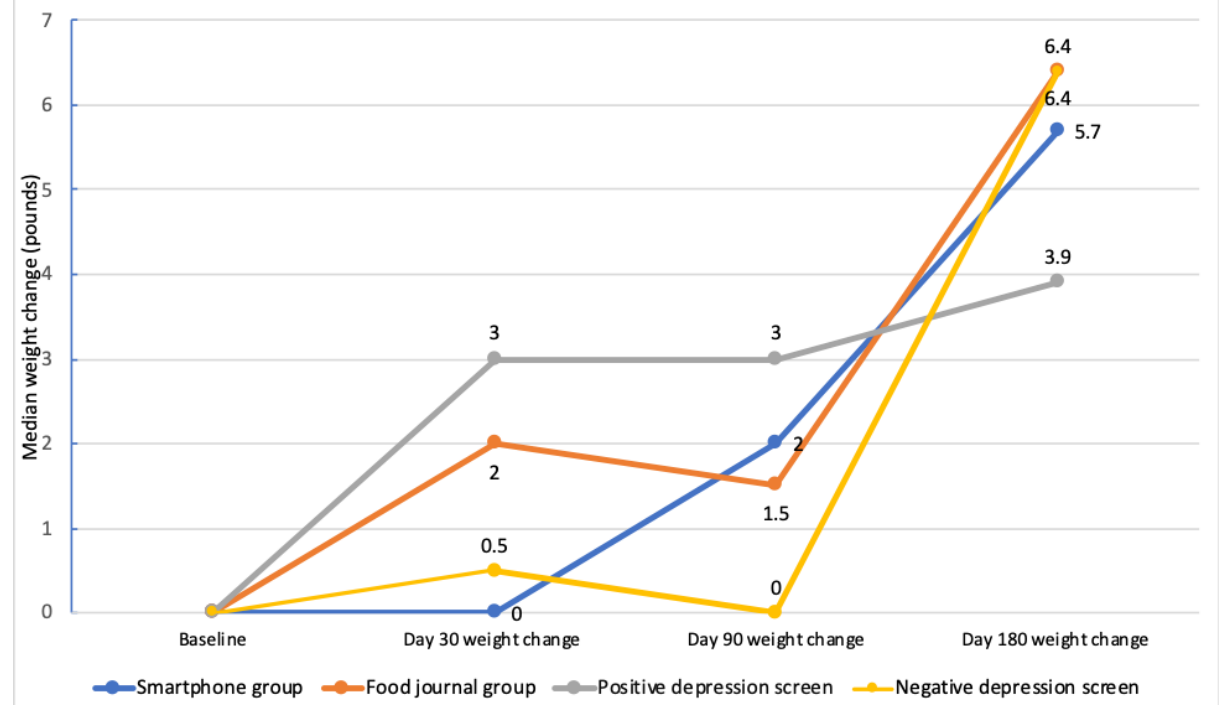
Figure 3. Median weight change by intervention group and depression status.